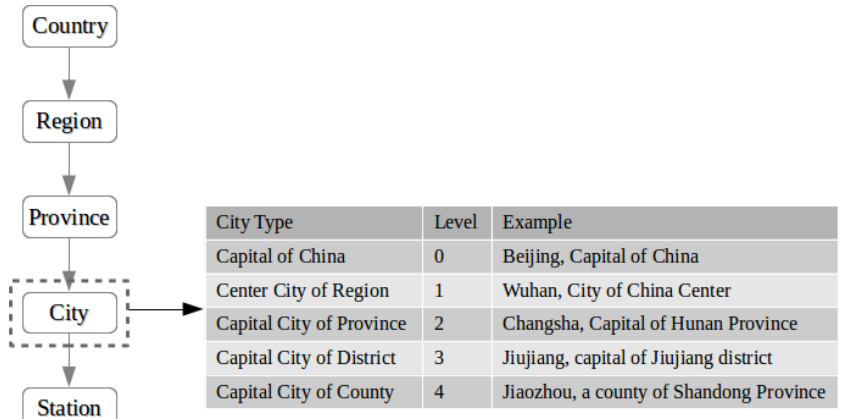
Figure 2. Hierarchical structure of the geographical dimension. In this paper, we focus on the city level, and the importance weight is in the table on the right